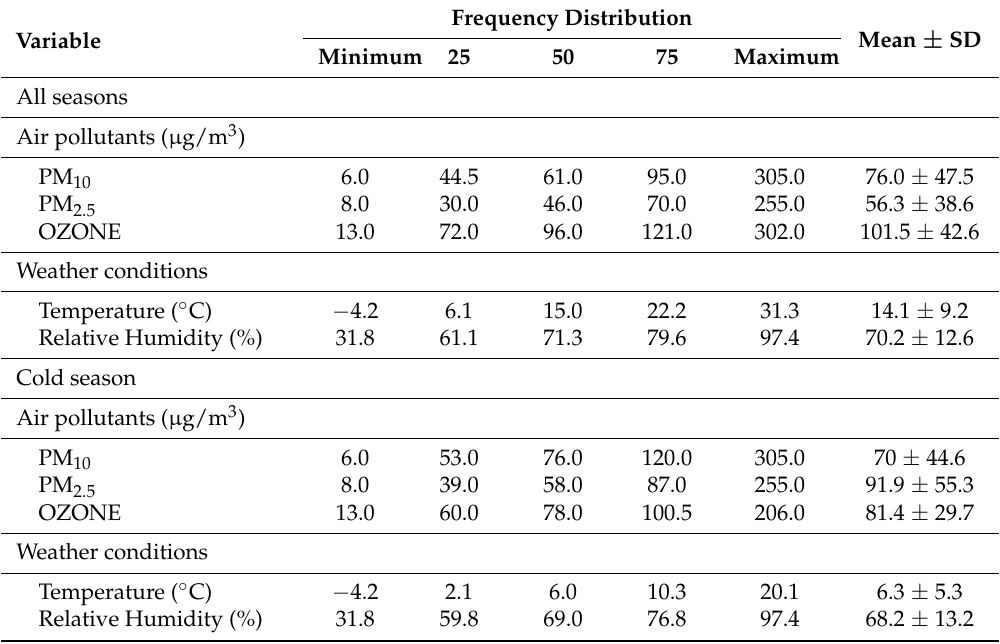
Table 2. Summary of daily air pollutants and weather conditions in Shanghai in